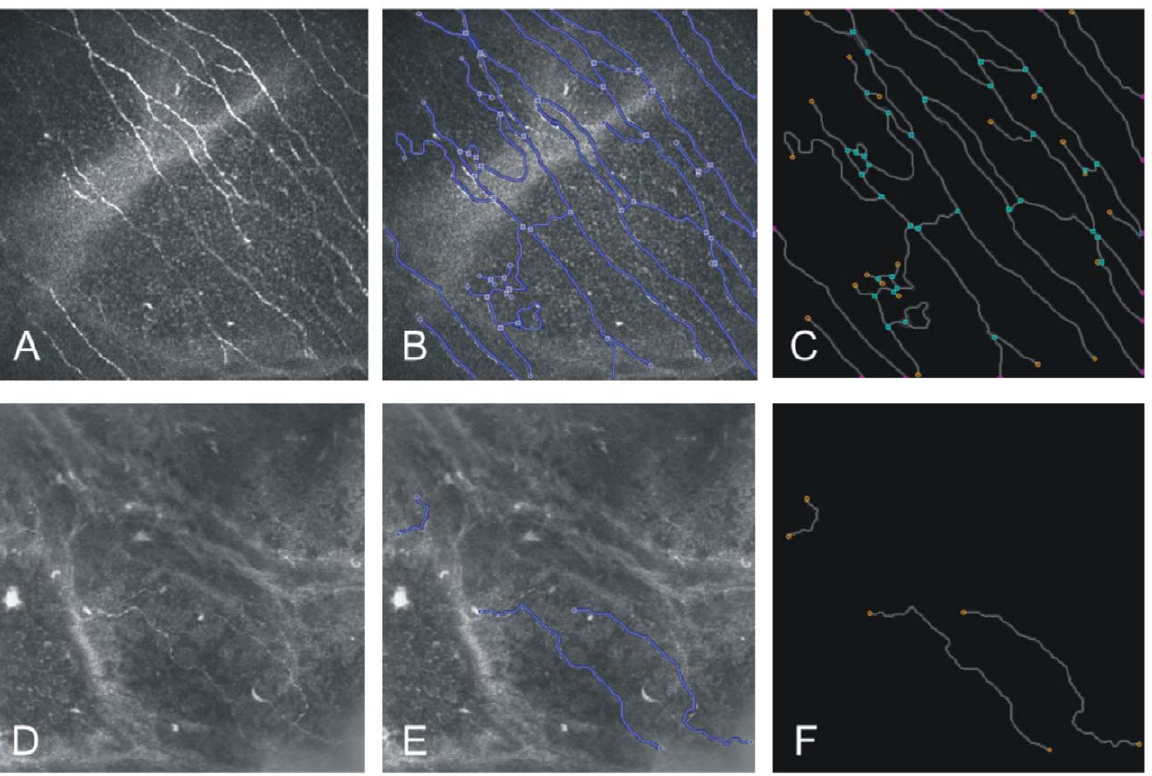
Figure 2. Confocal microscopy and quantification of micromorphological parameters. Initial image of SBP in the central cornea obtained with in vivo CLSM in a healthy volunteer (A) with corneal sensation 60 mm and diabetic patient (D) with corneal sensation 40 mm and NDS=8 (image size: 400 x 400 m m). B and E represent the results of segmentation from the corresponding SBP images in control and diabetic subjects, respectively. C and F show graphs displaying the geometry of SBP in a final surface reconstruction. Total fibre length of 4706 and 545.4 m m, nerve fibre density 0.034 mm/mm 2 and 0.004 mm/mm 2 , and single nerve fibre count 68 and 3 were measured in control subject and diabetic patient, respectively. doi:10.1371/journal.pone.0052157.g002 significant difference for separation between the two groups was with 90% (18 out of 20) in control group and 100% in diabetic achieved using only the variables component ratio and nerve fibre group. density: in total 95% (36 out of 38 cases) were correctly classified